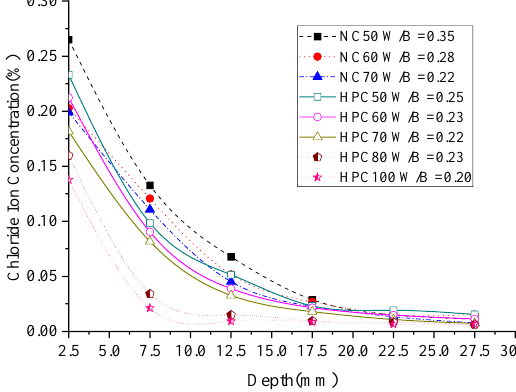
Figure 5. Chloride concentration distribution of Group I specimens.